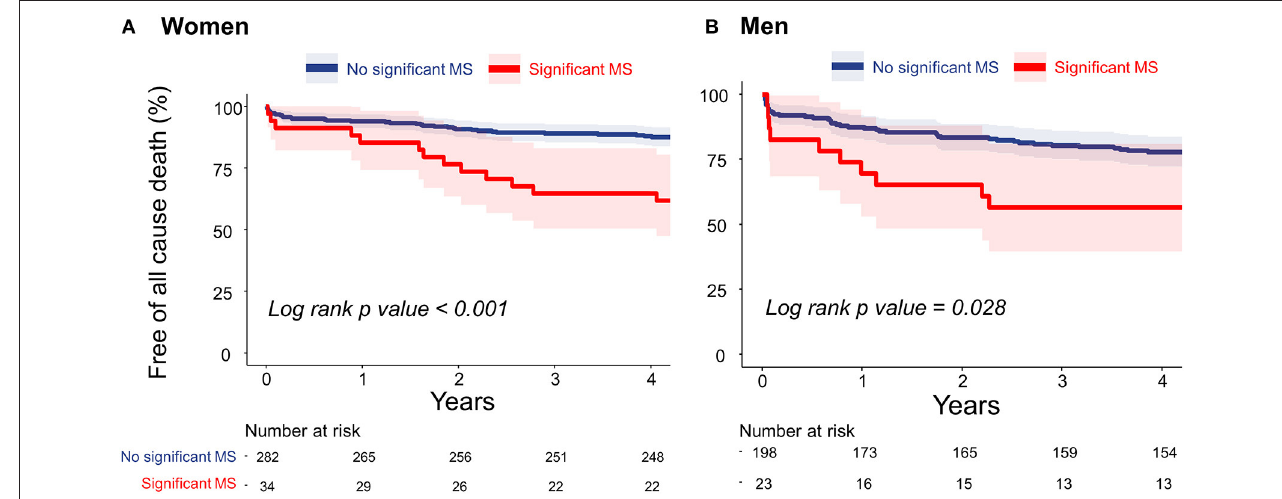
FIGURE 2 | Cumulative incidences of all-cause death in women (A) and men (B) estimated using the Kaplan–Meier method. MS, mitral